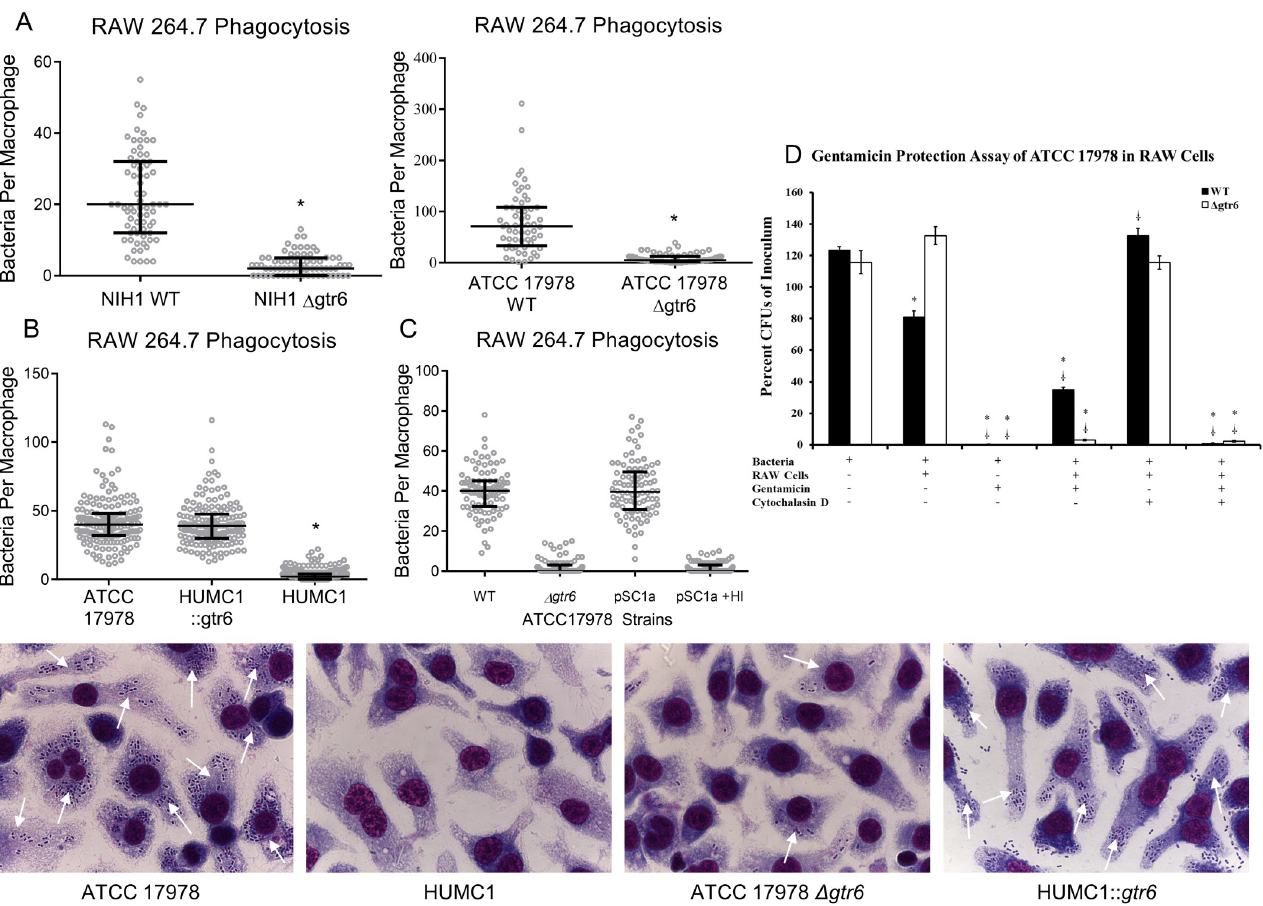
Fig 2. Macrophage phagocytosis of ATCC 17978 Δ gtr6 , NIH1 Δ gtr6 , and HUMC1::gtr6, gentamycin protection assay, and representative micrographs. (2A) RAW 264.7 cells were co-incubated with NIH1 (left) and ATCC 17978 (right) isogenic wild-type strains and Δ gtr6 mutants. (2B) RAW 264.7 cells were co- incubated with ATCC 17978, the HUMC1:: gtr6 mutant strain with repaired gtr6 , or wild-type HUMC1. (2C) RAW 264.7 cells were co-incubated with ATCC 17978 wild type, Δ gtr6 , Δ gtr6 /pSC1a (the knockout mutant with a plasmid-borne functional copy) in the presence of complement-active serum, and Δ gtr6 /pSC1a in the presence of heat-inactivated serum. � p < 0.001. (2D) Gentamicin protection assay with RAW 264.7 cells and wild-type ATCC 17978 (black bars) or ATCC 17978 Δ gtr6 (white bars). Cytochalasin D was added as an inhibitor of phagocytosis. Total bacteria plated for CFUs and expressed as a proportion of initial bacterial inoculum. � = significant vs. bacteria-only group, y = significant vs. bacteria + RAW 264.7 cell group. � , y = p < 0.01 (2E) RAW 264.7 cells were incubated with ATCC 17978, HUMC1, ATCC 17978 Δ gtr6 , and HUMC1:: gtr6 . Stained with Wright-Giemsa stain, total magnification is 1000x. Results are from two repeat experiments with duplicate samples in each. White arrows denote adherent or internalized